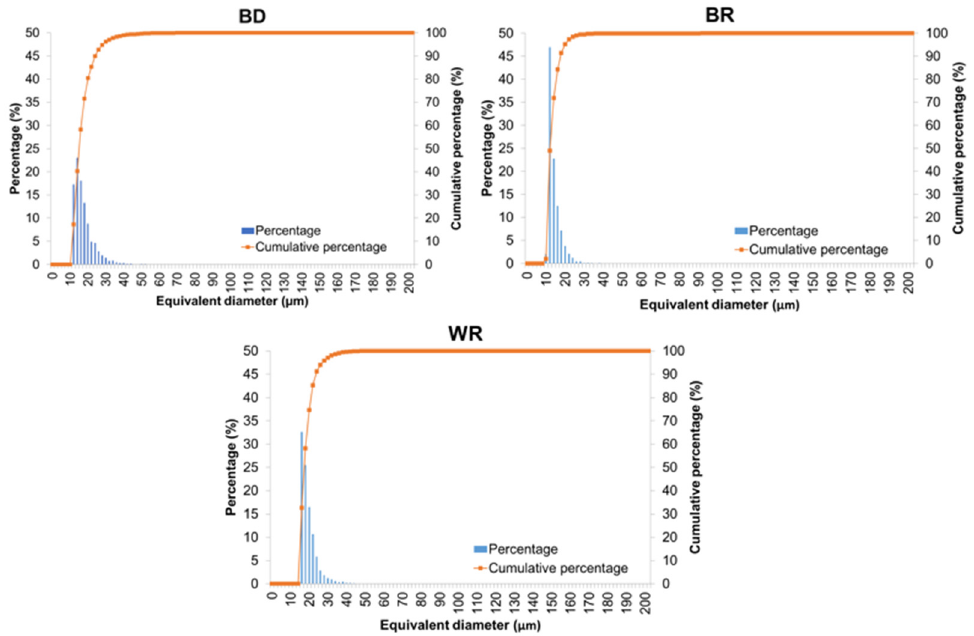
Figure 2. Histograms of the distribution of pore equivalent diameter obtained by X-ray tomography analysis in the case of Biodentine™ (BD), MTA Biorep (BR), and Well-Root PT (WR). Table 2. Pore volume fraction and average pore equivalent diameter obtained by X-ray tomography analysis in the case of Biodentine™ (BD), MTA Biorep (BR), and Well-Root PT (WR).